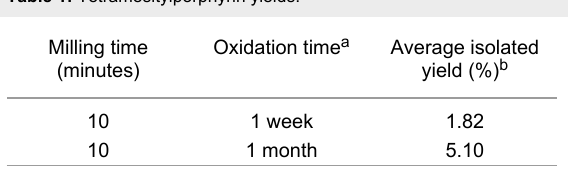
Table 1: Tetramesitylporphyrin yields. Milling time